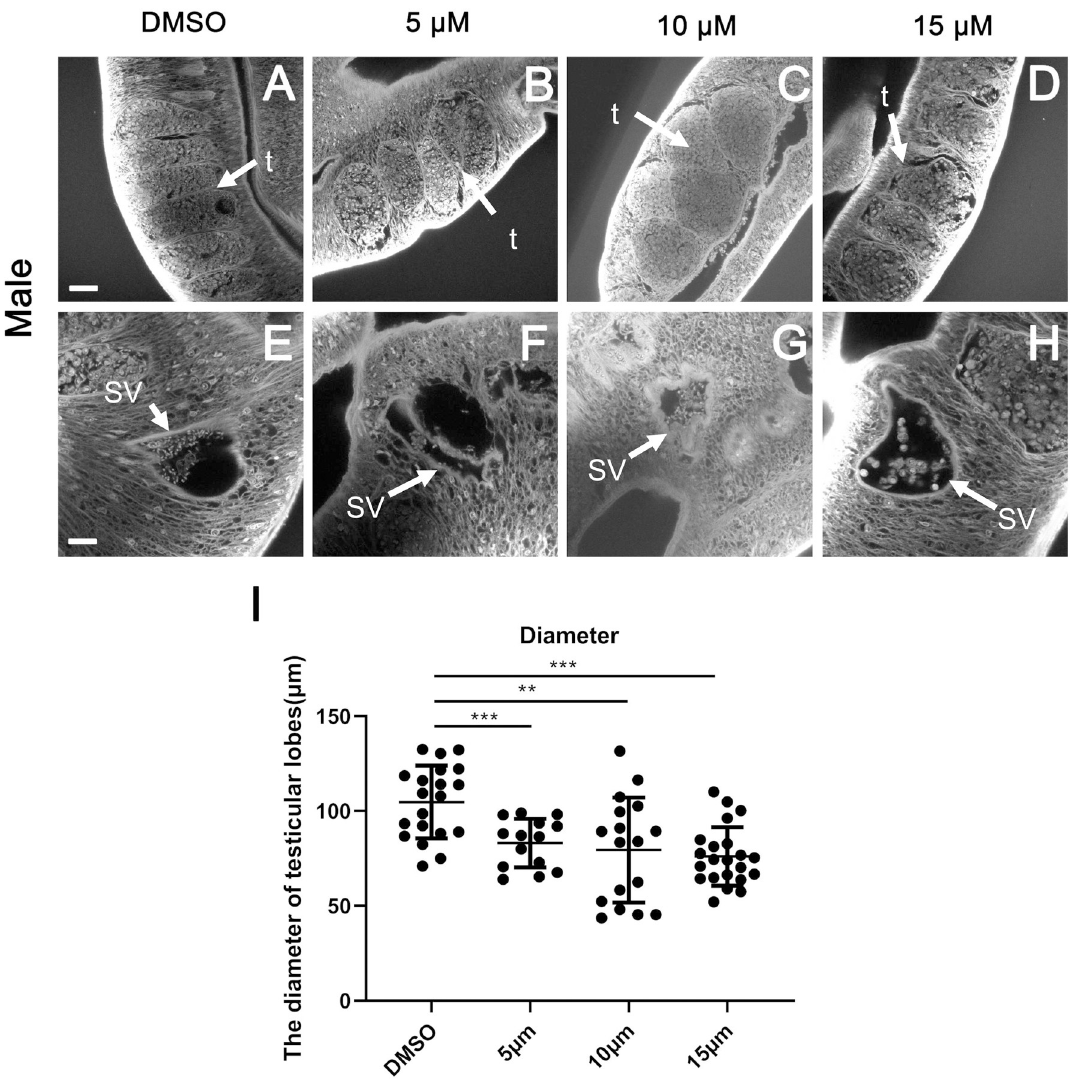
Fig 3. Morphological changes of spermatozoa in testes and seminal vesicles of S . japonicum treated with JQ-1 in vitro. Worms were stained with carmine hydrochloride and analyzed using confocal laser scanning microscopy. (A, E) Control worms; worms treated with JQ-1 at 5 μ M (B, F), 10 μ M (C, G), and 15 μ M (D, H). (A-D) Scale bars: 20 μ m; (E-H) Scale bars: 10 μ m. Abbreviations: t, testis; SV, sperm vesicle. (I) Comparison of the diameter of the testicular lobes after JQ-1 application at the indicated concentration for 10 d. Data represent the mean ± SEM (n � 15 for each group). Asterisks show statistical differences ( �� P < 0.01; ��� P < 0.001) tested by one-way ANOVA with multiple comparisons. livers obtained from mice in the HP- β -CD group had large agglomeration, and granuloma inflammation was severe. However, there was marked reduction of liver surface granuloma- tous nodules in the JQ-1-treated group. The livers obtained from mice in the JQ-1-treated group were lighter and more vivid in color, and the surface was relatively smooth, compared with the livers from mice in the control group. Hematoxylin and eosin staining of the liver showed that the percentage of the area of the liver that had granulomas in the JQ-1-treated group was significantly reduced compared with that in the HP- β -CD control group (Fig 6C) ( P < 0.01). In addition, the weights of the liver and spleen obtained from mice treated with JQ-1 were significantly lower than those from control mice (Fig 6D and 6E). Moreover, the